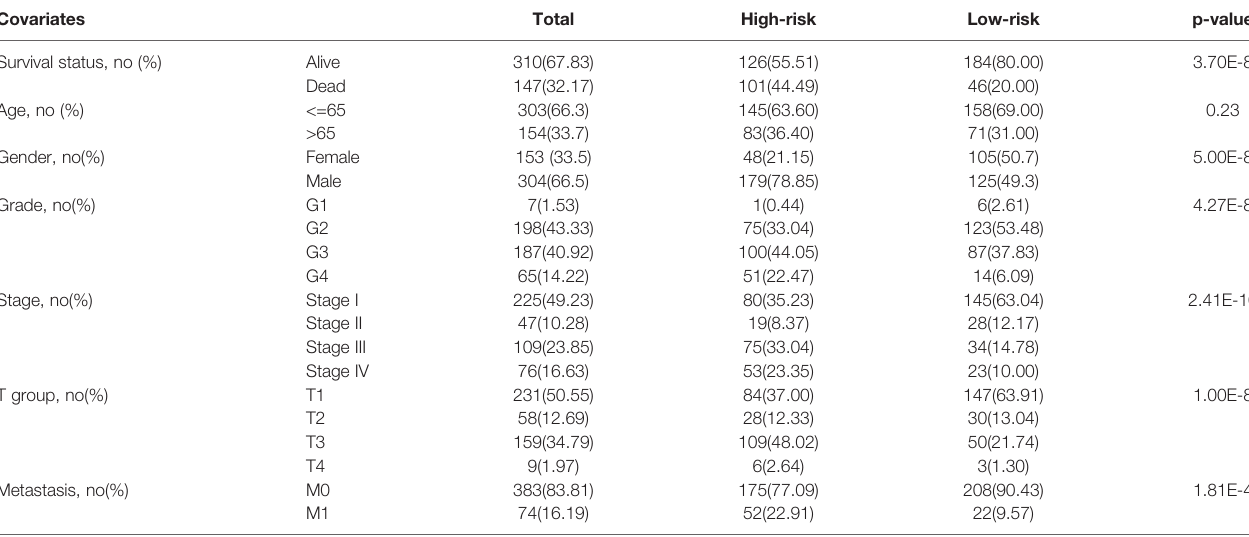
TABLE 3 | Clinical features of patients in high-risk and low-risk groups and chi-square test between two groups. Covariates Total High-risk Low-risk p-value Survival status, no (%)